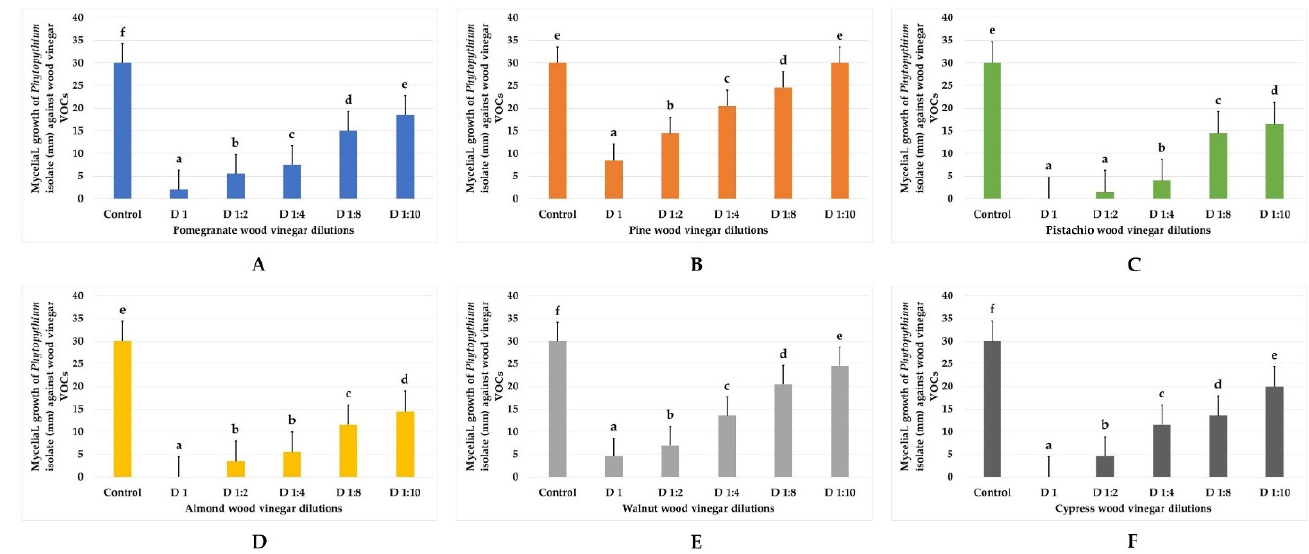
Figure 4. Bar charts of effectiveness of different wood vinegars against Phytopythium sp. (ON409943). Pomegranate wood vinegar dilutions ( A ); pine wood vinegar dilutions ( B ); pistachio wood vinegar dilutions ( C ); almond wood vinegar dilutions ( D ); walnut wood vinegar dilutions ( E ); cypress wood vinegar dilutions ( F ). Bars labeled with different letters represent significant differences among the treatments at p < 0.05 using Tukey’s HSD test.